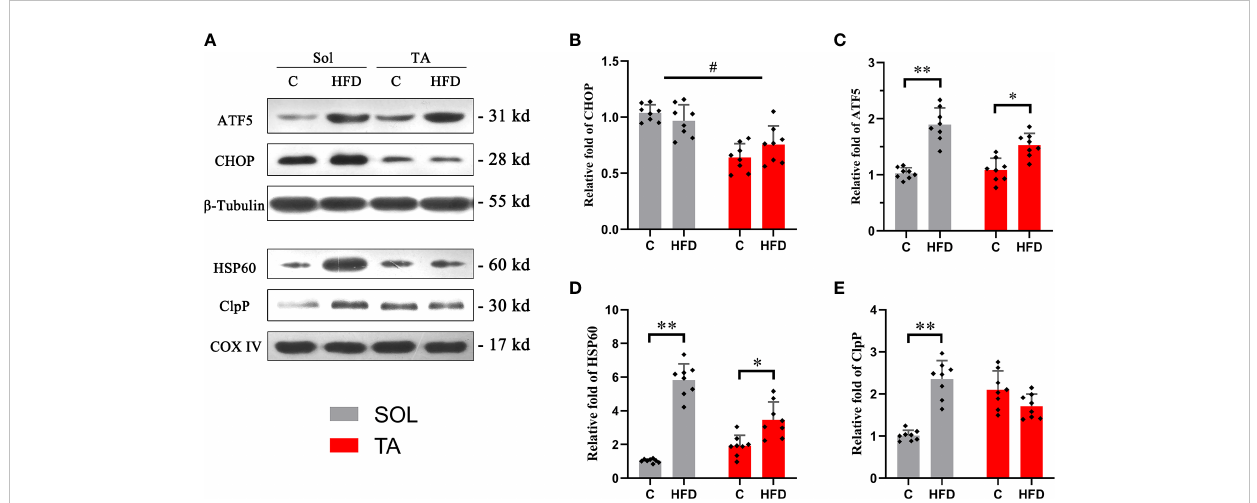
FIGURE 4 The relative expression of UPRmt markers in Sol and TA muscles. (A) The original western blots of CHOP and ATF5 from muscle lysates; HSP60 and ClpP from isolated mitochondria. (B, C) Quanti fi cation of the relative expression of CHOP and ATF5 in Sol and TA in each group. (D, E) Quanti fi cation of the relative expression of HSP60 and ClpP in Sol and TA in each group. (*p<0.05; **p<0.01; and #p<0.05 when comparison was conducted between muscles; n=8 for each